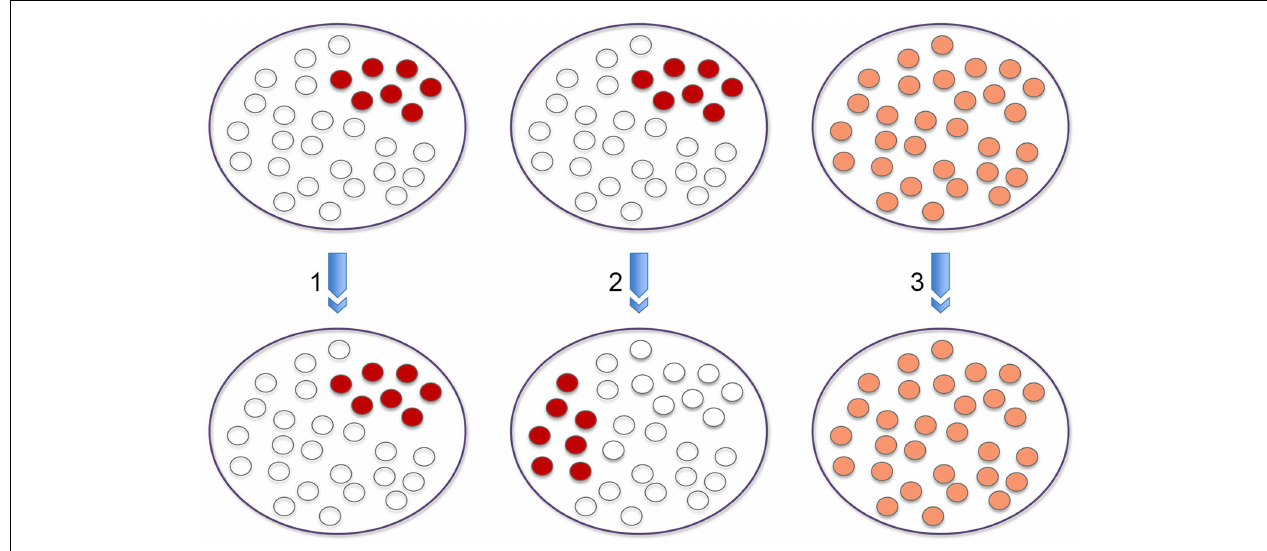
FIGURE 1 | Population versus single cell analysis .The three panels provide different outcomes at the single cell level that explain signal enrichment from a population based chromosome conformation capture experiment that reflects interaction between two loci. Signal enrichment could reflect interaction at high frequency in only a subset of cells within the population